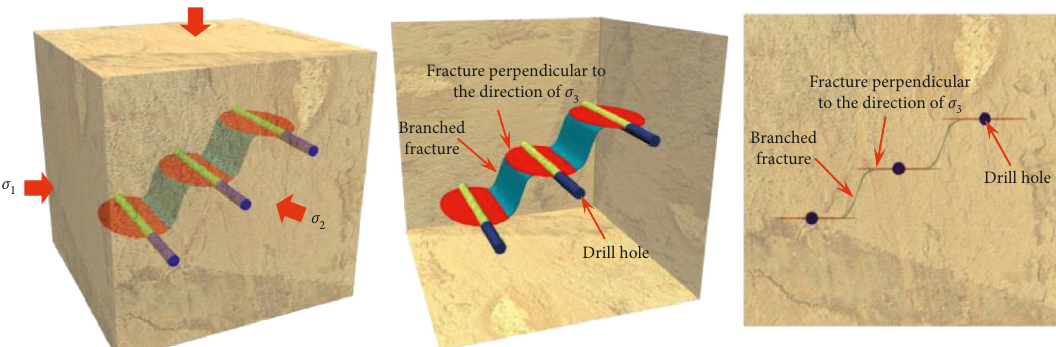
Figure 11: Three-dimensional configuration of hydraulic